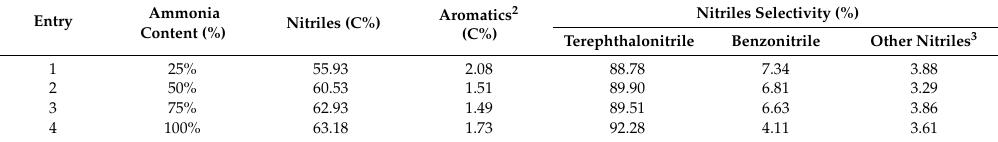
Table 2. E ff ect of ammonia content in the carrier gas on selectively producing terephthalonitrile.